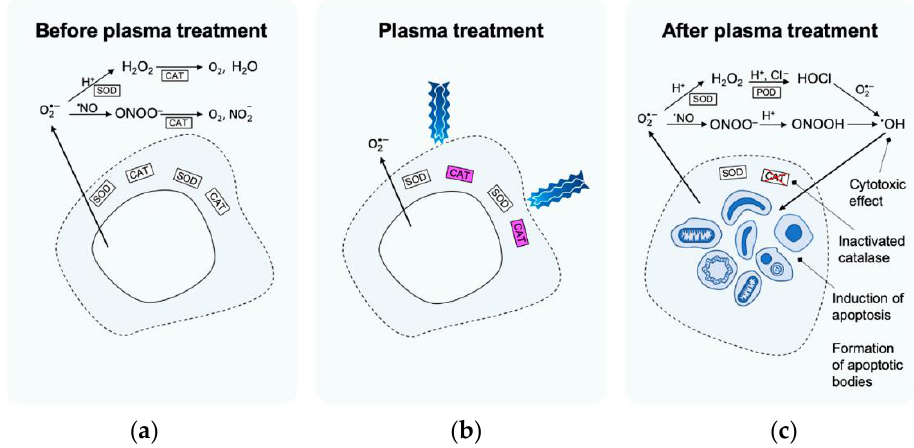
Figure 8. Proposed set of events forming the basis of the mechanism of apoptosis induction in selective LTP cancer treatment [200]: ( a ) before plasma treatment, ( b ) plasma treatment, ( c ) after plasma treatment